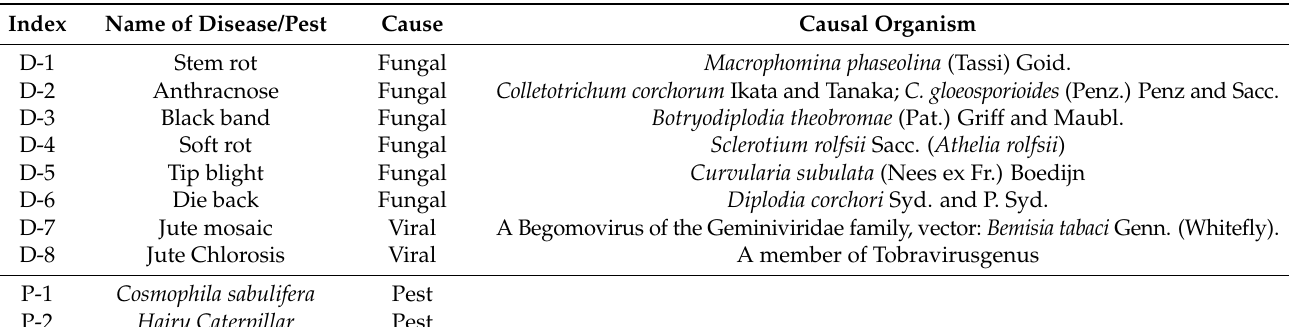
Figure 2. Some sample images from our jute diseases and pests dataset. ( a ) the stem rot disease. ( b ) the anthracnose disease. ( c ) the black band disease. ( d ) the soft rot disease. ( e ) the tip blight disease. ( f ) the dieback disease. ( g ) the jute mosaic disease. ( h ) the jute chlorosis disease. ( i ) the Cosmophila sabulifera caterpillar on a jute leaf. ( j ) some Hairy Caterpillars on a jute leaf. Table 1. The indices and causes of Jute diseases and pests.